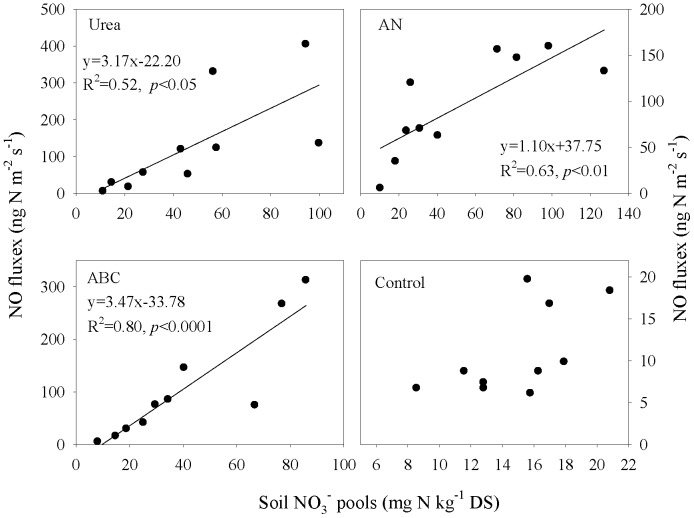
Correlation between NO fluxes and soil NO3
− pools (n = 10).Each value is the mean of three replicates.